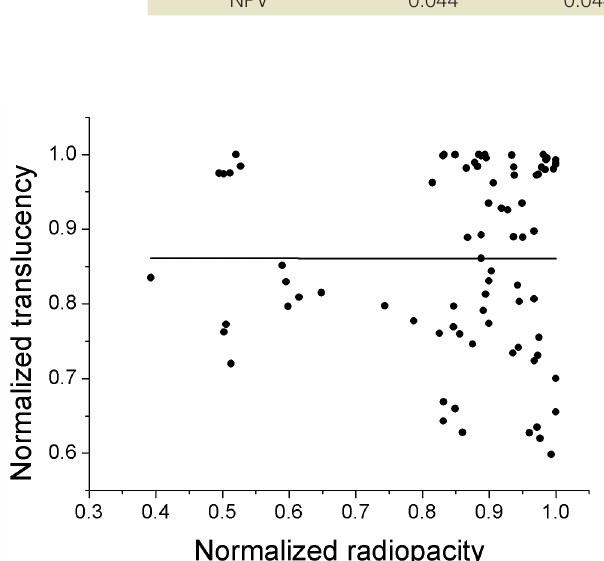
Figure 3. Plot of normalized radiopacity against normalized translucency showing no correlation (black line = Pearson’s correlation fit; R 2 = -0.013). N = 80 histological